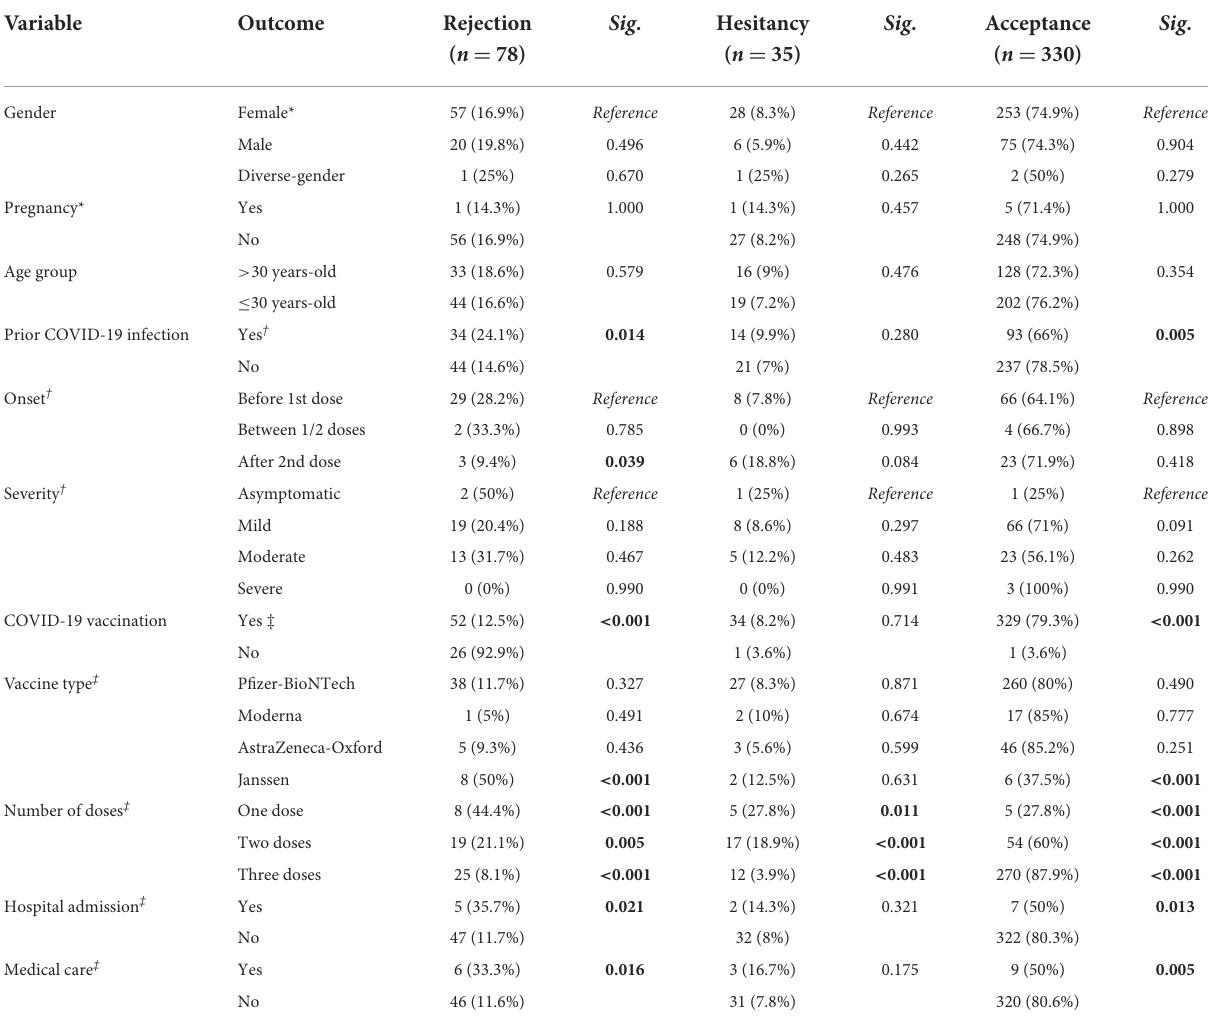
TABLE 5 Demographic and anamnestic determinants of COVID-19 vaccine booster acceptance among polish healthcare professionals and students responding to COVID-19 VBH survey, December 2021–January 2022 ( n =